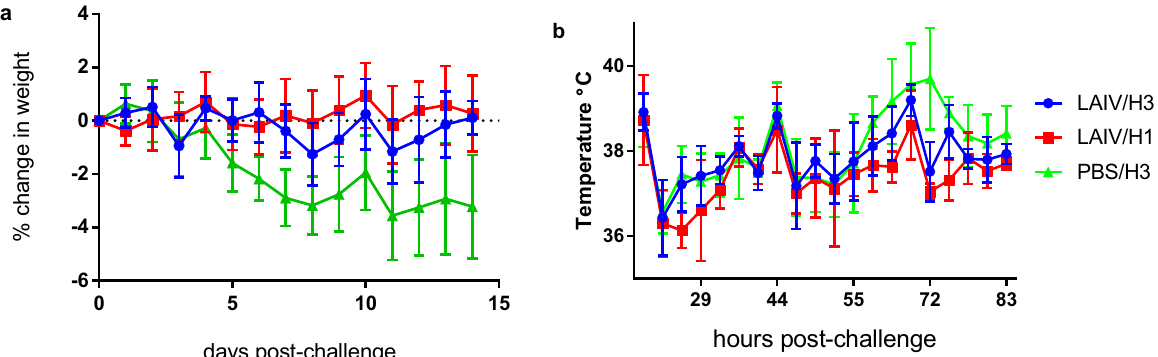
Fig. 6 Protection from clinical disease conferred by LAIV vaccination. a Loss of bodyweight, normalised to day of challenge. b Temperature post-challenge. Group means and SD are plotted ( n = 6).